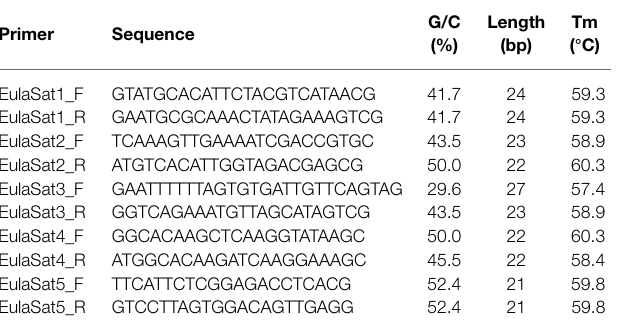
TABLE 2 | Primer pairs for the generation of satDNA clones.